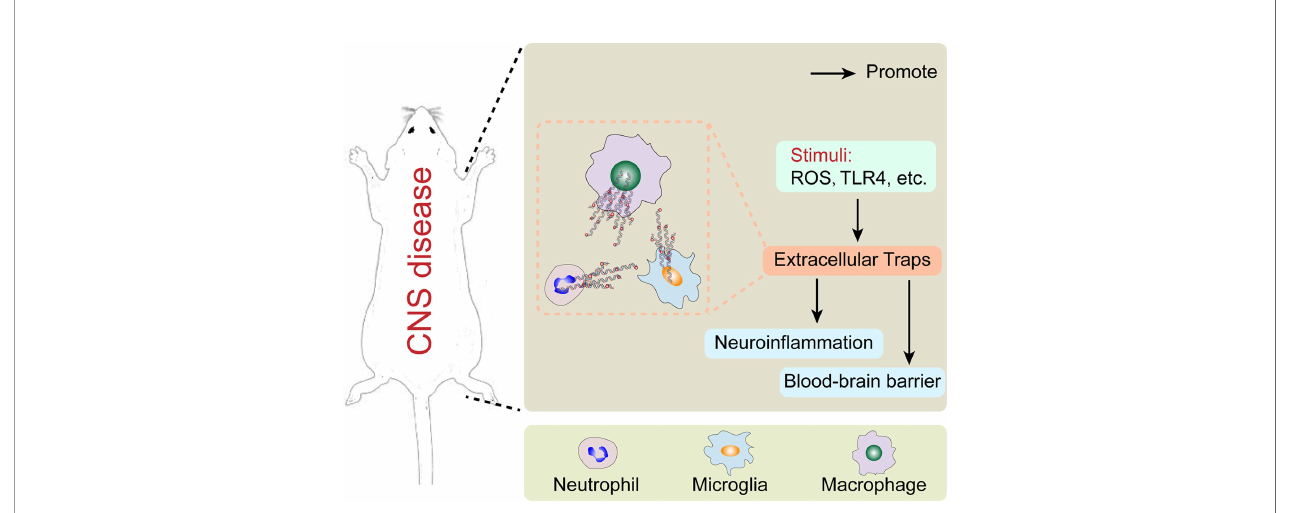
FIGURE 1 | The major cells forming extracellular traps in central nervous system disease and their potential